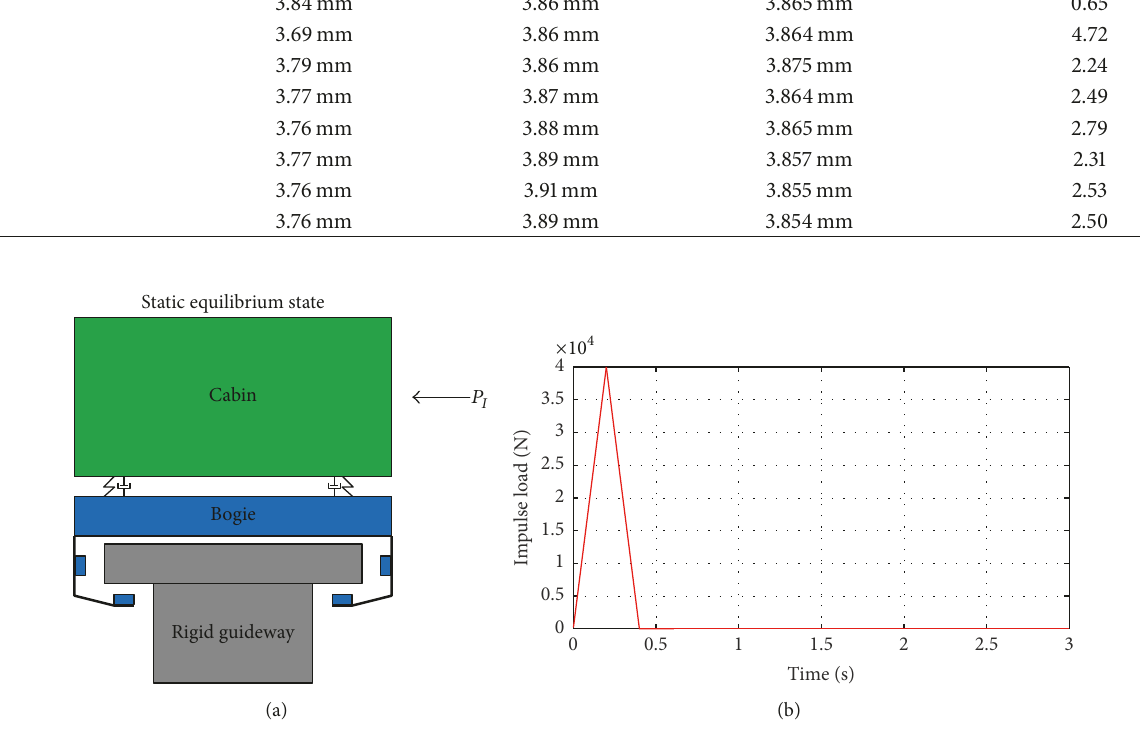
Figure 9: Maglev vehicle subjected to lateral impulse load in stop and steady state: (a) maglev vehicle in stop and steady state, (b) lateral impulse